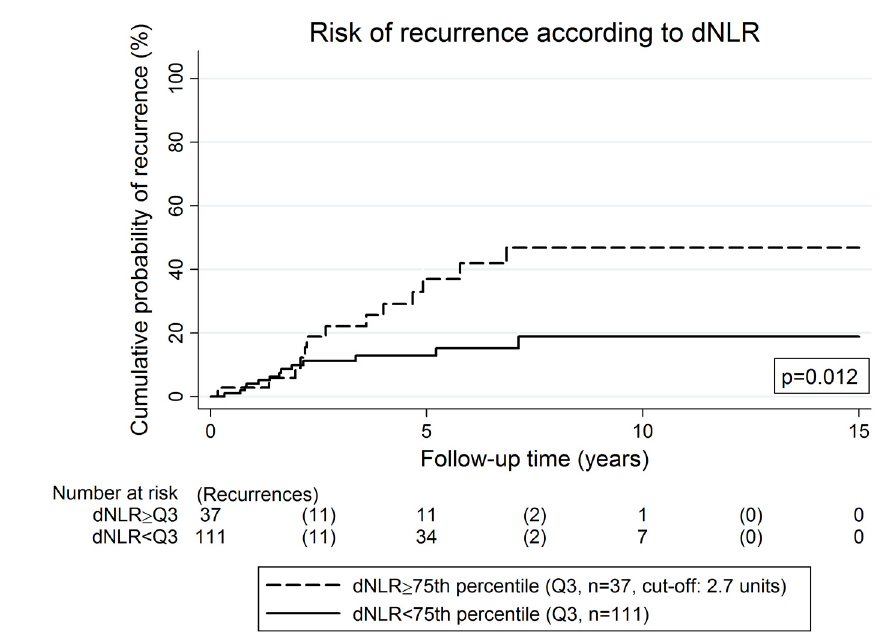
Fig 3. Risk of recurrence according to the derived neutrophil lymphocyte ratio (dNLR) at baseline. Patients with an elevated dNLR at baseline had a significantly higher risk of developing recurrence. The risk of recurrence (defined as a composite of local recurrence and/or distant metastasis, whatever came first) was estimated using competing risk cumulative incidence estimators with death-from-any-cause as the competing event of interest. The boxed p-value was estimated using Gray ’ s test. The dNLR was dichotomized into a binary variable at its 75 th percentile (i.e. Q3, cut-off: 2.7